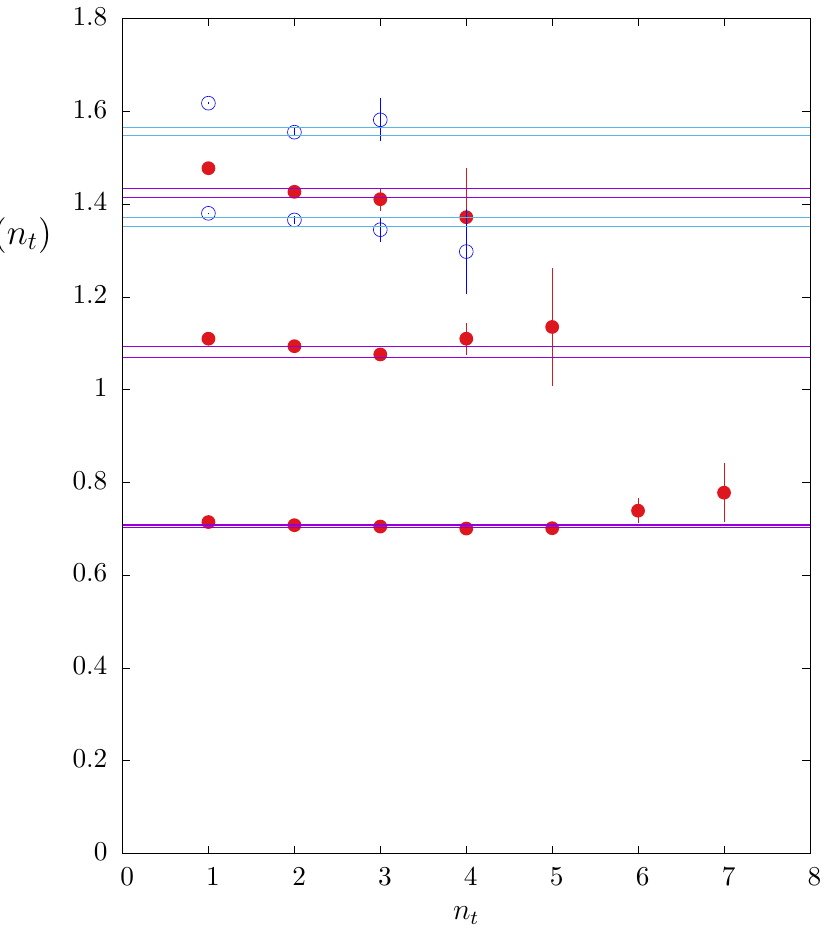
Figure 4 . E(cid:11)ective masses of the lightest (cid:12)ve J P = 0 + glueballs in SO(12) at (cid:12) = 155. Lines are (cid:6) 1 (cid:27) mass